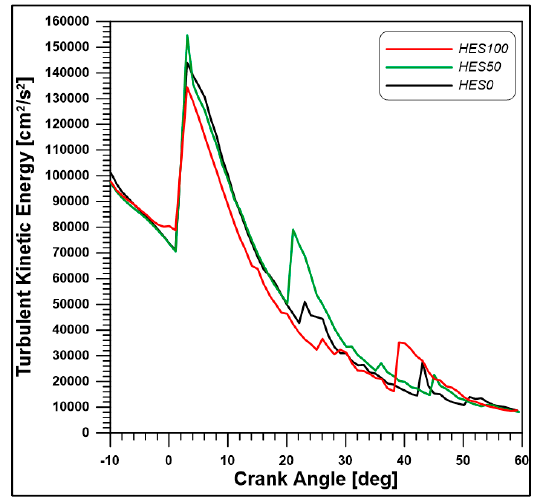
Figure 27. Turbulent kinetic energy.